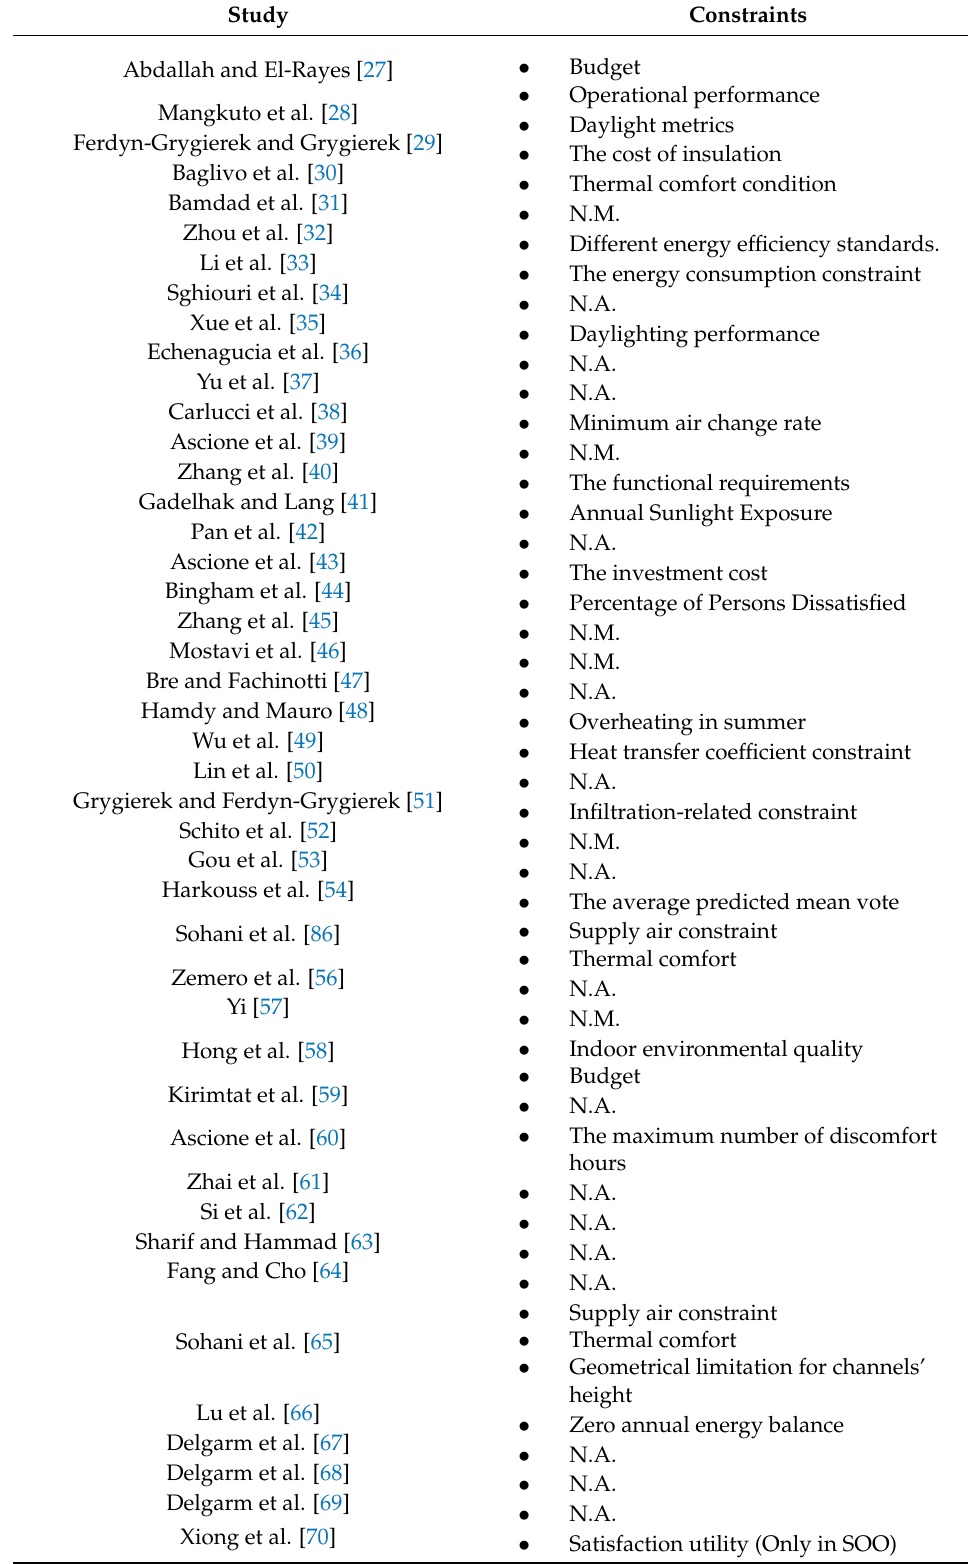
Table 5. Constraints which have been considered in the core